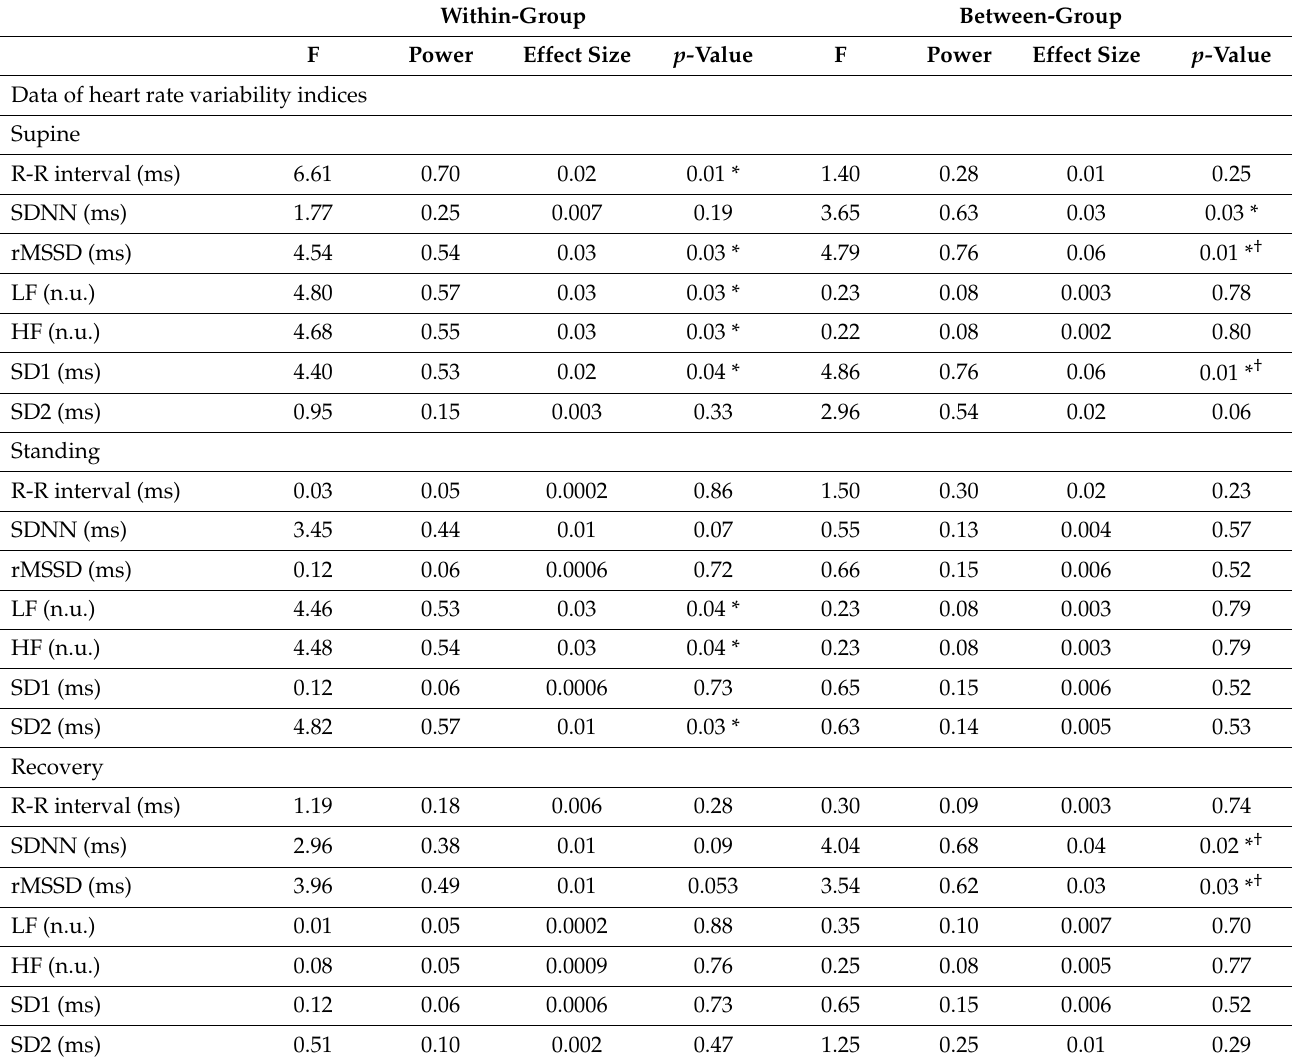
Table 1. Between-group and within-group comparisons for the heart rate variability indices in the three moments analyzed, excluding participants who used beta-blockers (N = 41). Within-Group Between-Group F Power Effect Size p- Value F Power Effect Size p-